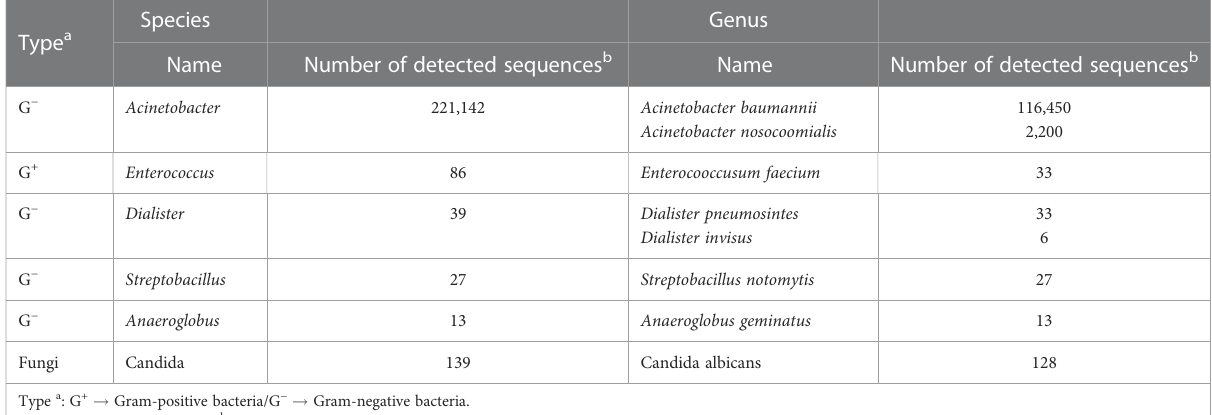
TABLE 1 Detected bacteria and fungi in BALF by